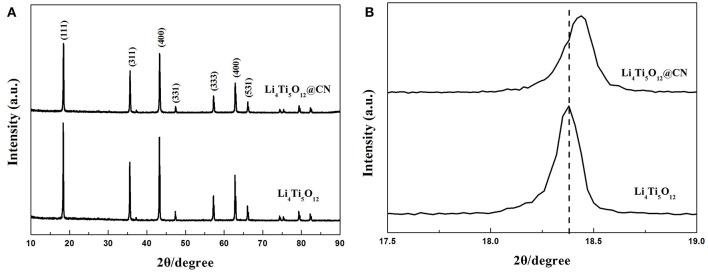
(A) X-ray diffraction profiles of Li4Ti5O12 and Li4Ti5O12@CN composite, (B) Enlarged (111) peak of Li4Ti5O12 and Li4Ti5O12@CN composite.